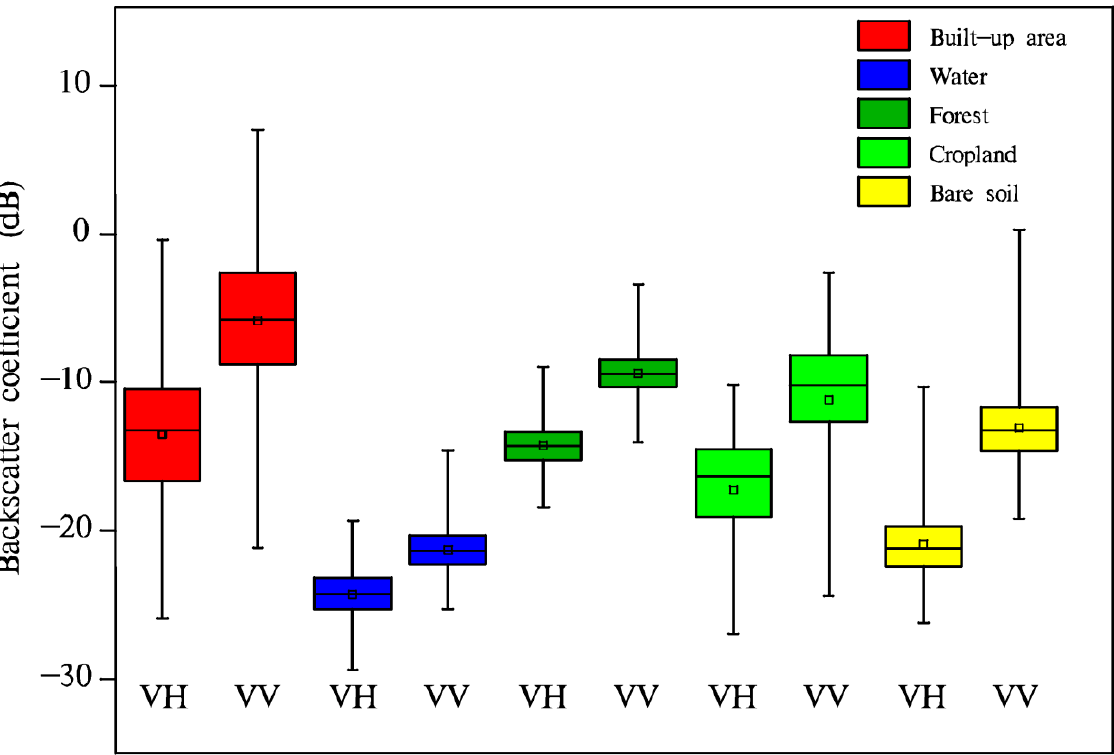
Figure 9. Box-and-whisker plot that represents the backscatter coefficient ( σ 0 ) values of five land cover categories.